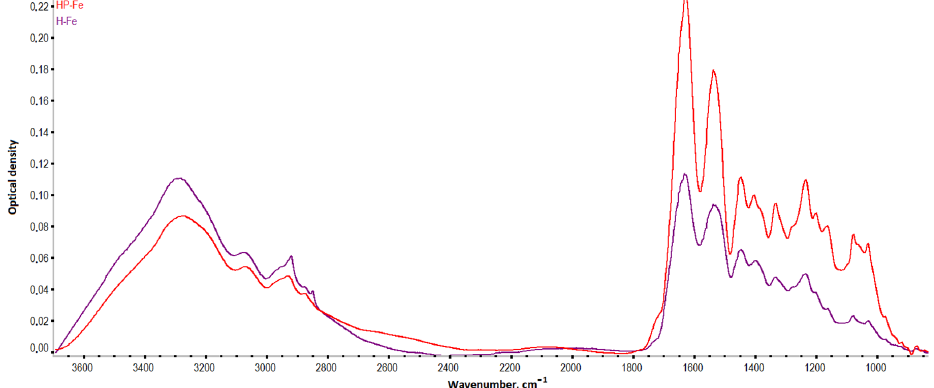
Figure 6. IR spectra of the hydrogels.